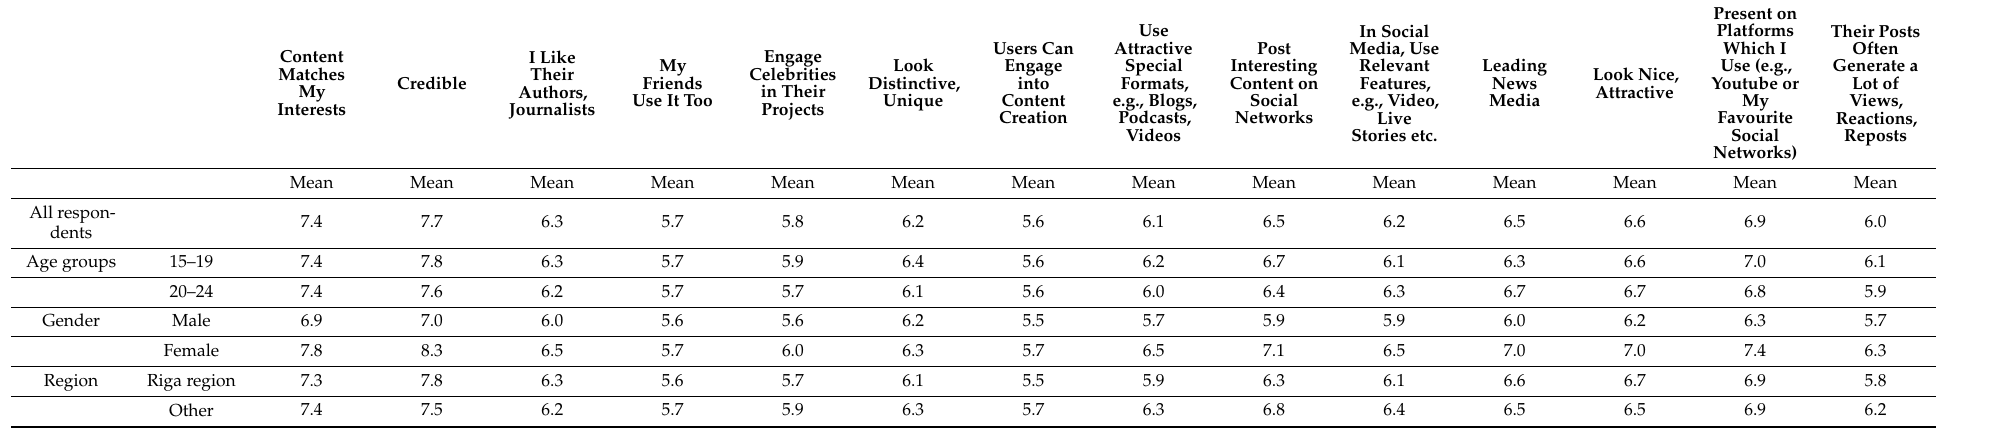
Table 5. The significance of each news media attribute, as evaluated by the audience, 15–25 years old,